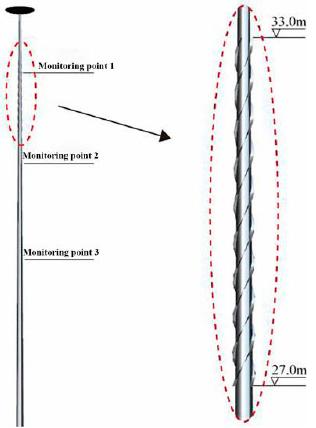
Figure 16. Elevation layout of spiral helical strakes.